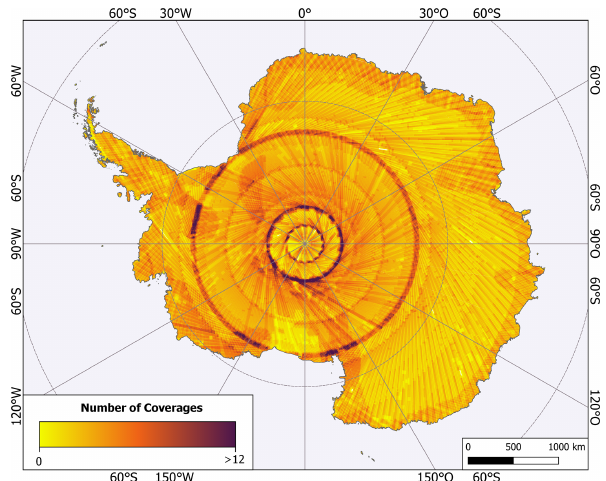
Figure 1. Number of coverages of TanDEM-X DEM data takes.